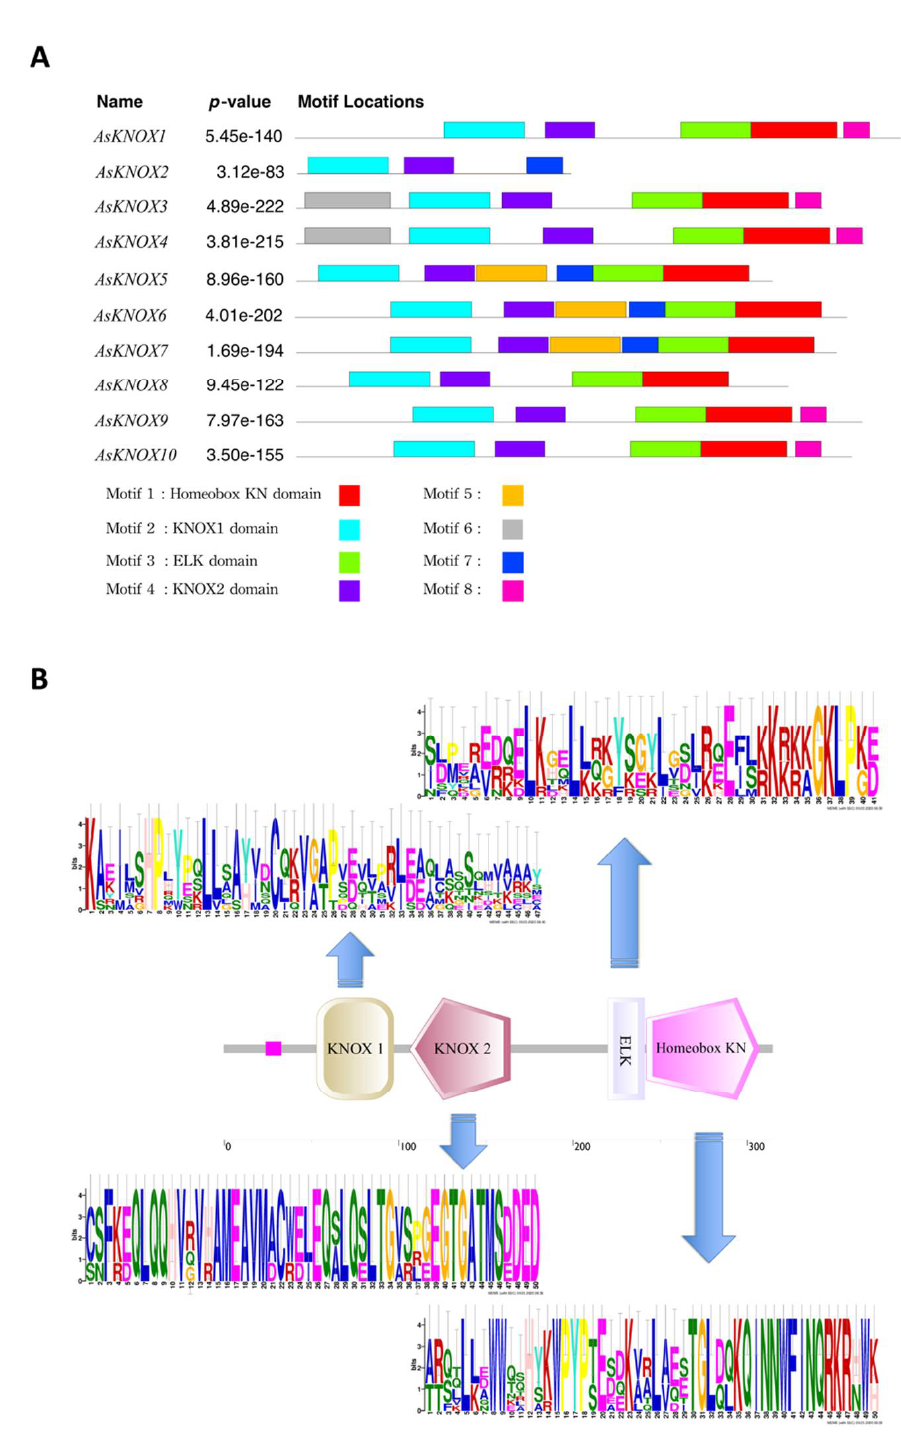
Figure 4. Conserved motif analysis of garlic AsKNOX homologs. ( A ) The conserved motifs within the 10 garlic AsKNOX proteins. Motif 1 to 8 were indicated with different colors; ( B ) The stacked motif logos of the KNOX1 domain, KNOX2 domain, ELK domain, and Homeobox KN domain.